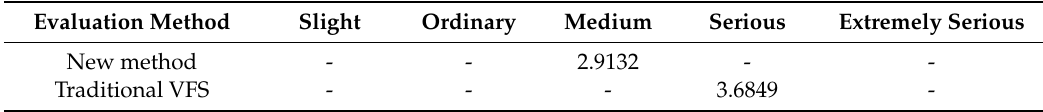
Table 7. Comparison of the dam break social impact assessment for the Liujiatai Reservoir conducted using di ff erent